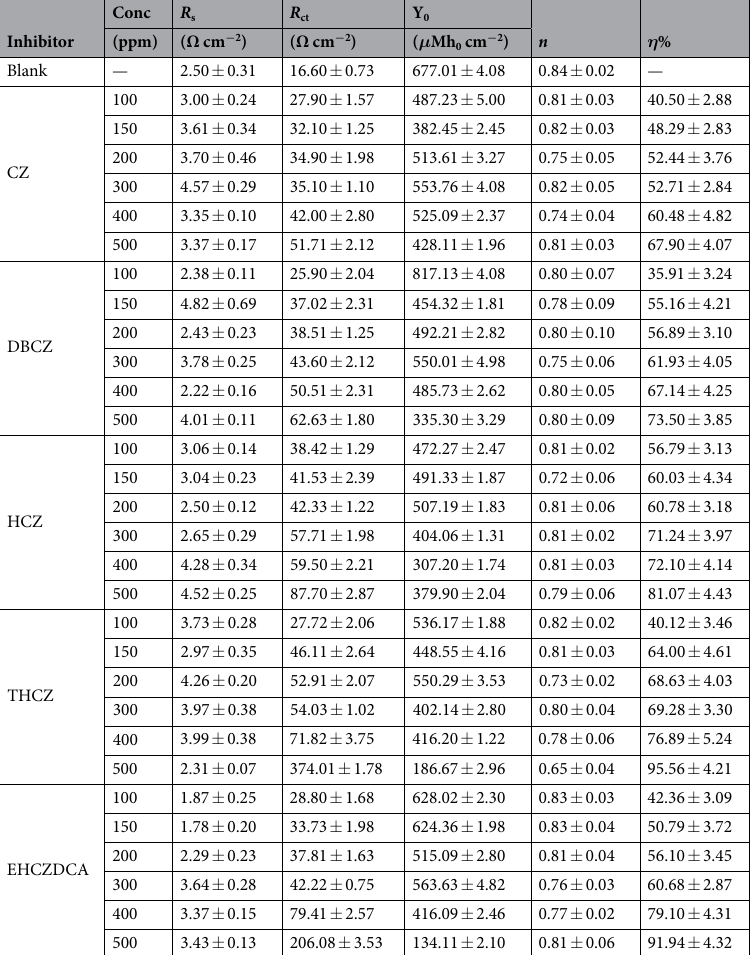
Table 3. Electrochemical impedance parameters obtained for MS in 1 M HCl in absence and presence of different concentration of